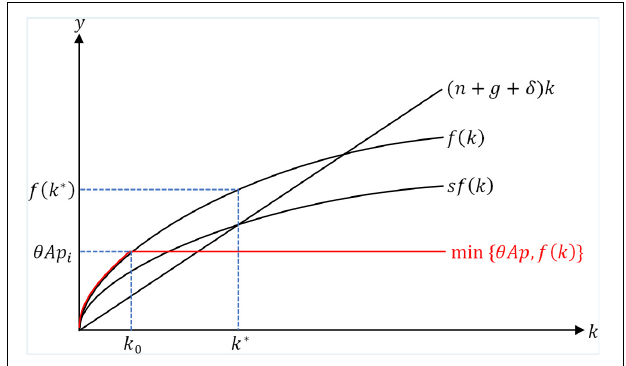
FIGURE 1 | Solow model with aggregate emission